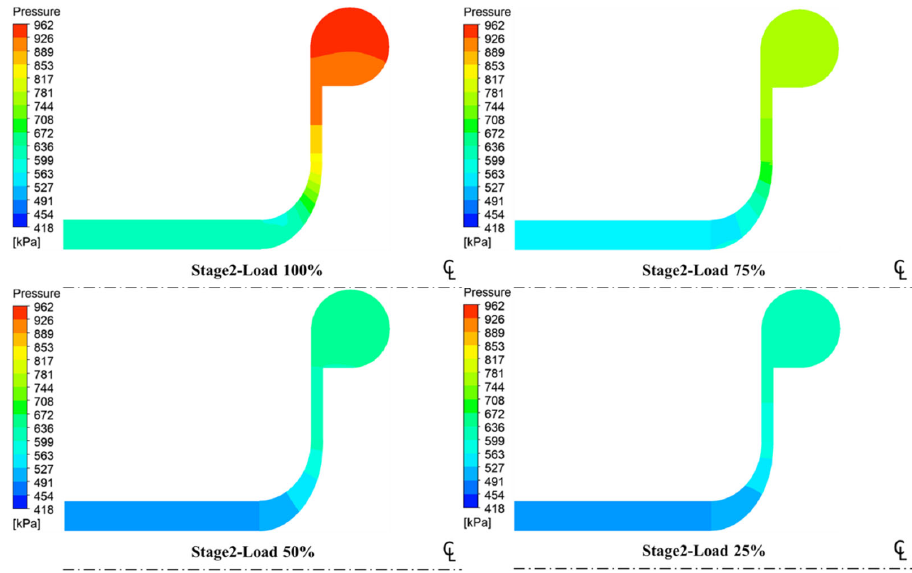
Figure 17. Pressure meridional contour maps of the second stage compression with R-513A refrigerant under various loads.